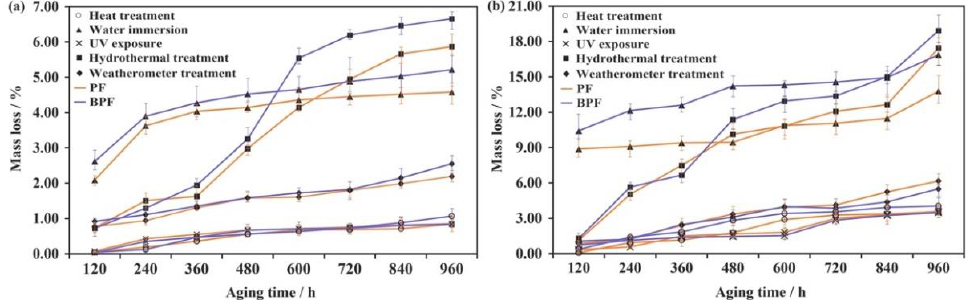
Figure 1. Variations in the mass loss of BPF and PF resins plywood ( a ) and films ( b ) under five aging conditions.